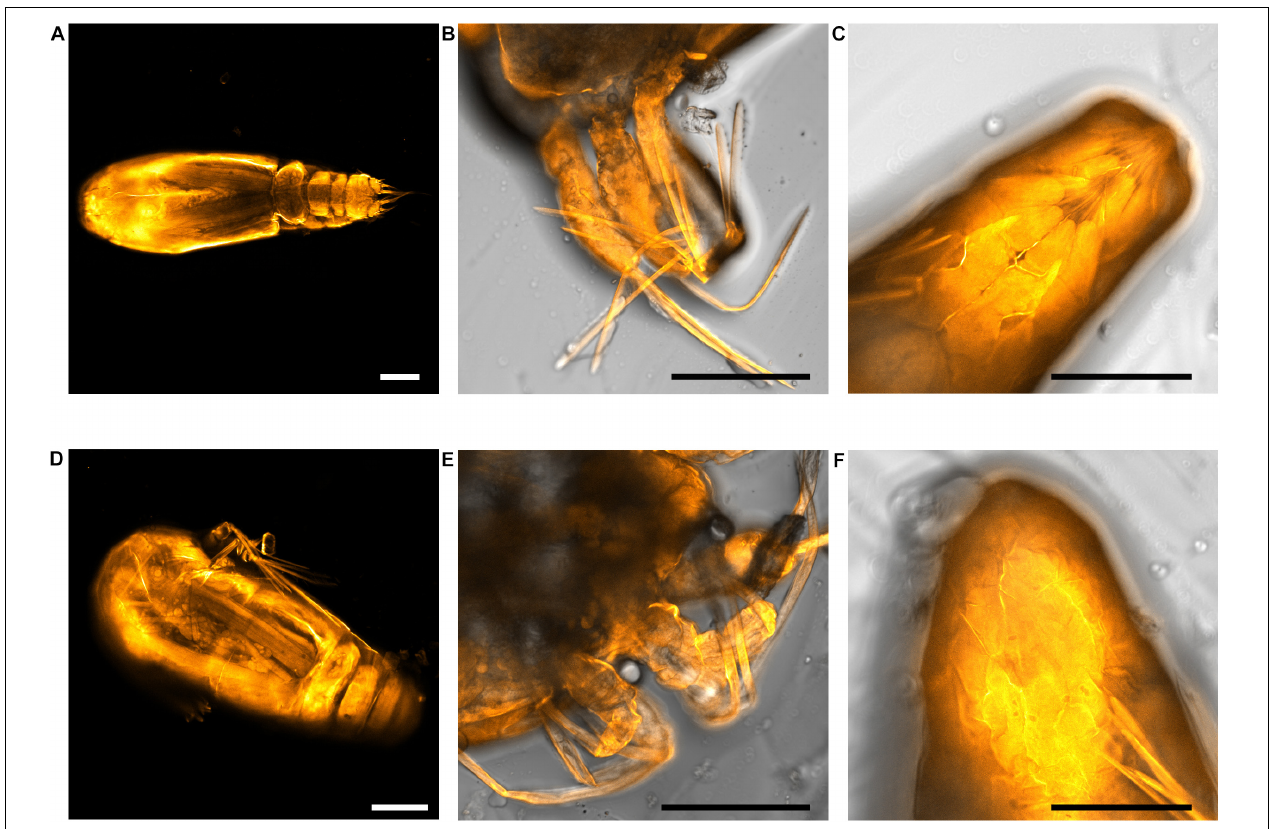
FIGURE 6 | Cuticle staining of lice larvae. Upper panel: dsCTRL control, and lower panel: ds PAH treatment. (A,D) Copepodites treated with ds PAH revealed the unorganized internal structure and developmental defects compared to control. The cephalothorax is not uniformly segmented and is poorly formed in ds PAH treated copepodites. (B,E) The external appendages in nauplius II were distorted in ds PAH treatment compared to the control. (C,F) The posterior segment of the nauplius II just after molting was symmetrically arranged, with a centrally positioned hindgut, but this symmetry was absent in treated individuals. Scale bars = 100 µ m.